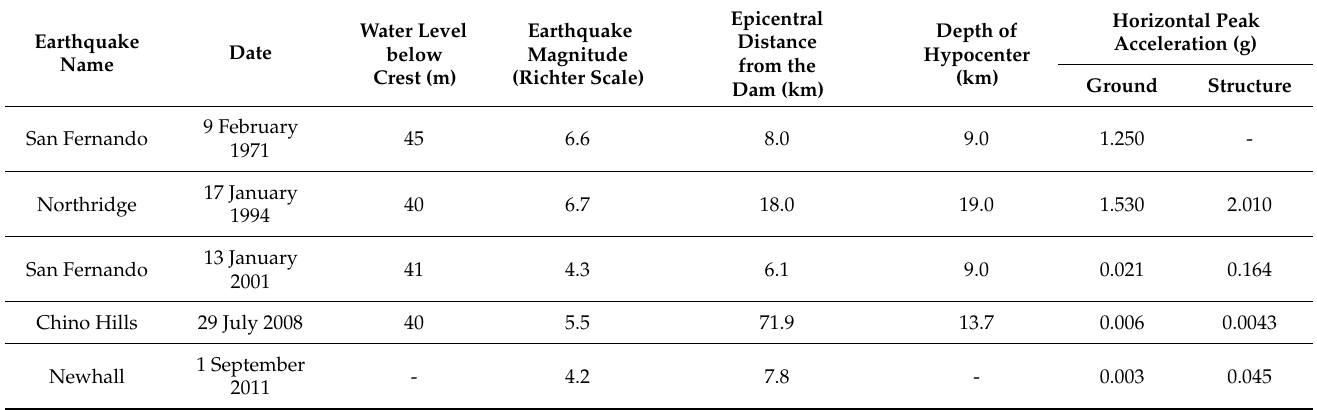
Table 2. The earthquakes of Pacoima arch